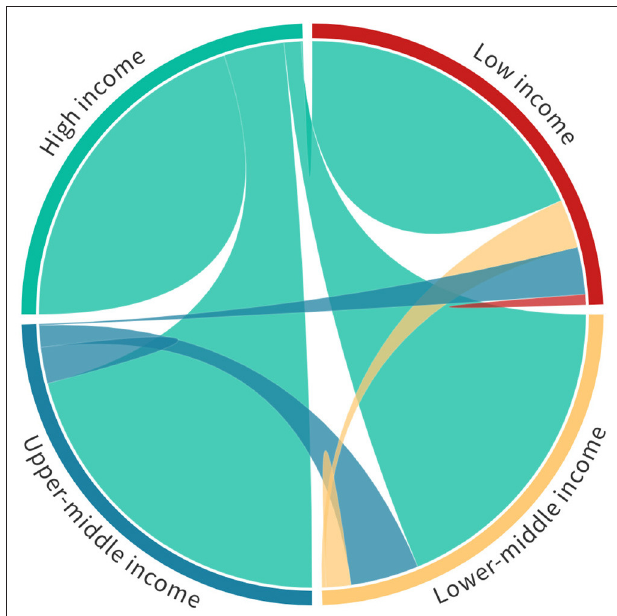
FIGURE 3 | Global collaboration between high-income, upper-middle-income, lower-middle-income, and low-income countries on publications between 2010 and 2020. Each quadrant in the chord diagram corresponds to 100% of the research output of countries in each of the brackets. Thus, low-income levels of output have not been normalized in proportion to that of lower-middle, upper-middle, and high-income countries. In this view we see the proportion of collaboration between different economic bands (defined in Table 2 ). A chord diagram visualisation is helpful to understand the interplay between bi-lateral relationships, but it is important to note that the representation is not entirely faithful as it cannot include multi-lateral relationships directly – a higher-dimensions representation would be required to encapsulate these relationships. However, the contributing bi-lateral component of a multi-lateral collaboration do contribute to each arc.